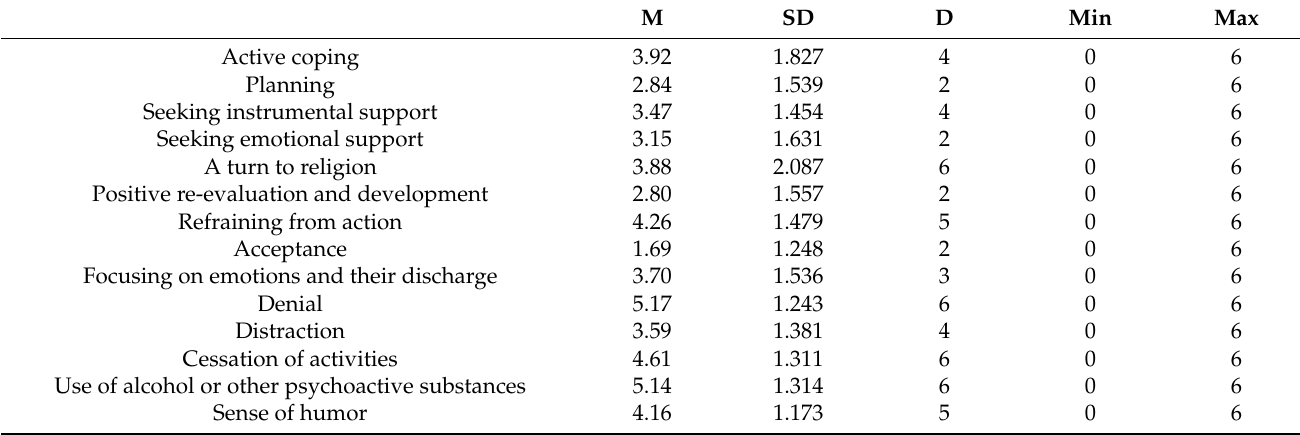
M—mean, SD—standard deviation,